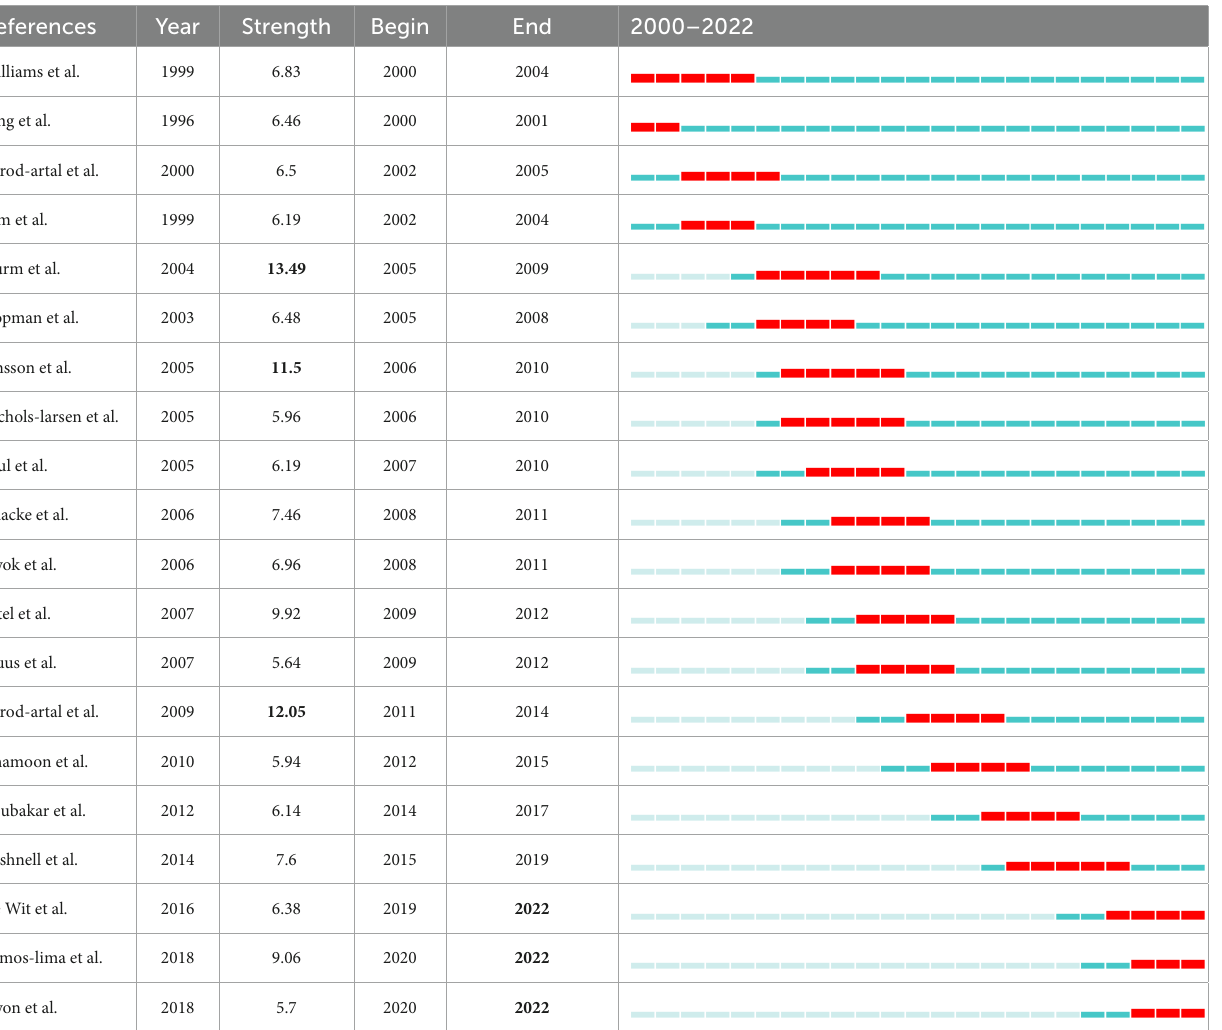
TABLE 9 Top 20 references with the strongest citation